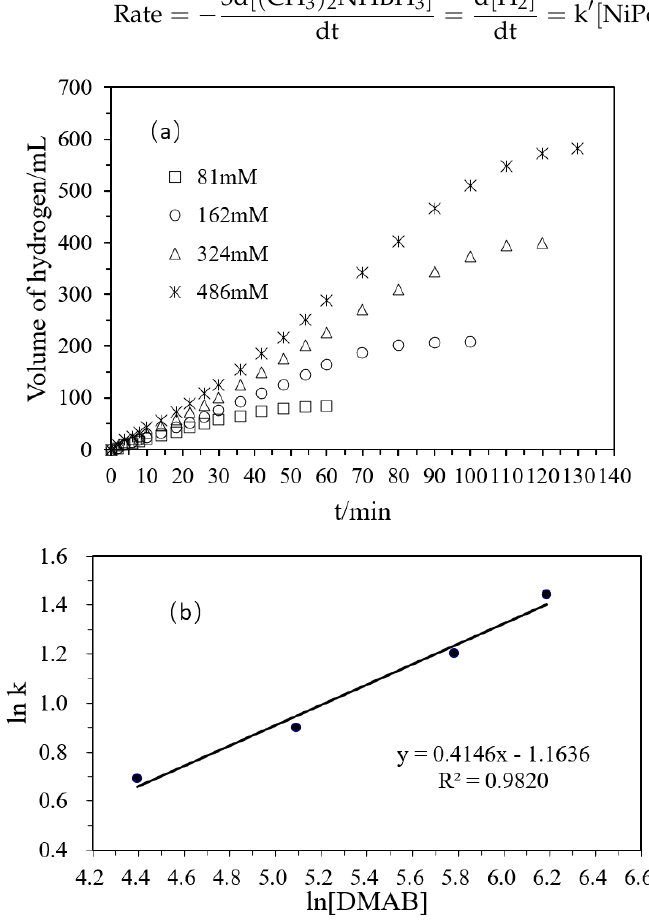
Figure 5. ( a ) Volume of hydrogen versus time plots for the hydrolysis of DMAB catalyzed by Ni/Pd nanoclusters (Ni/Pd = 20/1) (1 g) with different concentrations of DMAB (81, 162, 324, 486 mM) at 50 °C; ( b ) plot of the initial hydrogen production rate (k, in mL min −1 ) versus DMAB concentration 50 ◦ C; ( b ) plot of the initial hydrogen production rate (k, in mL min − 1 ) versus DMAB concentration (in logarithmic scale, y = 0.4146x − 1.1636). (in logarithmic scale, y = 0.4146x −